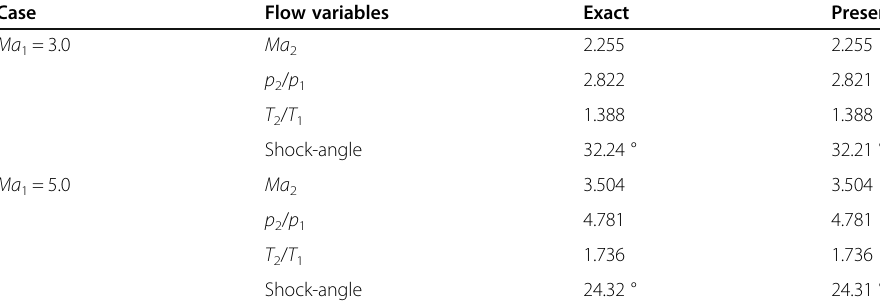
Table 1 Comparison of theoretical and present numerical results obtained from the supersonic oblique shock configuration Case Flow variables Exact Present Ma Ma 1 = 3.0 2